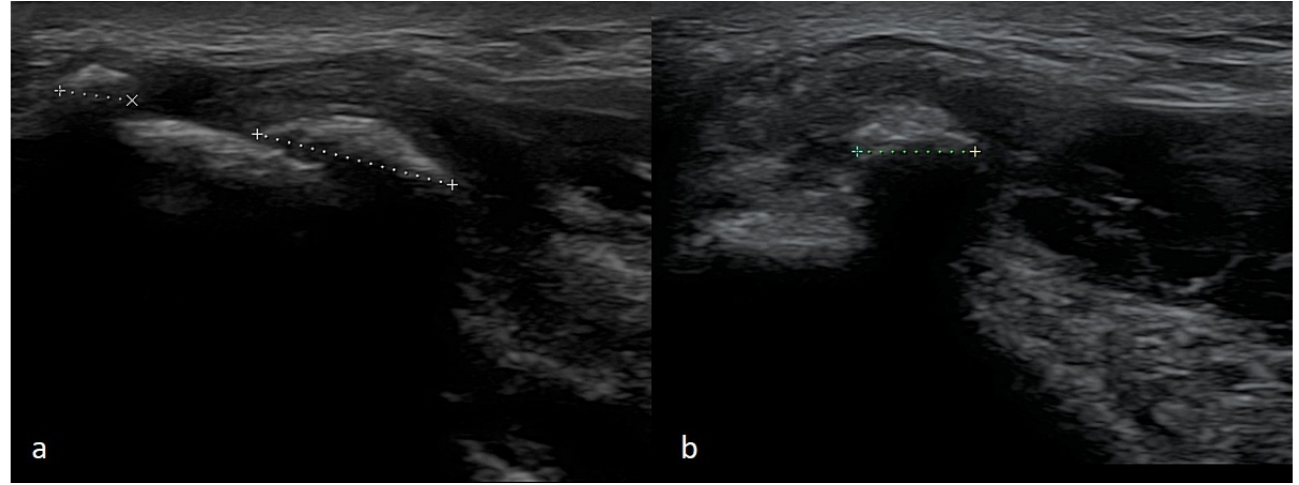
Figure 7. A case of advanced CFT enthesopathy with calcifications against damage within the flexor’s attachment structure. ( a )—Long-axis view, ( b )—short-axis view.